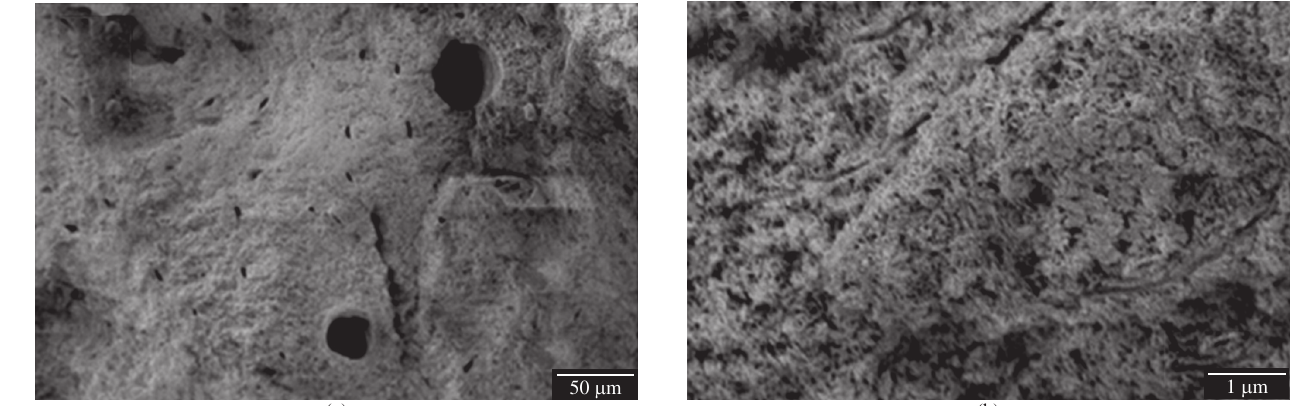
Figure 3. Scanning electron micrographs of HAp detailing the a) Haversian system and b) micro-pores.